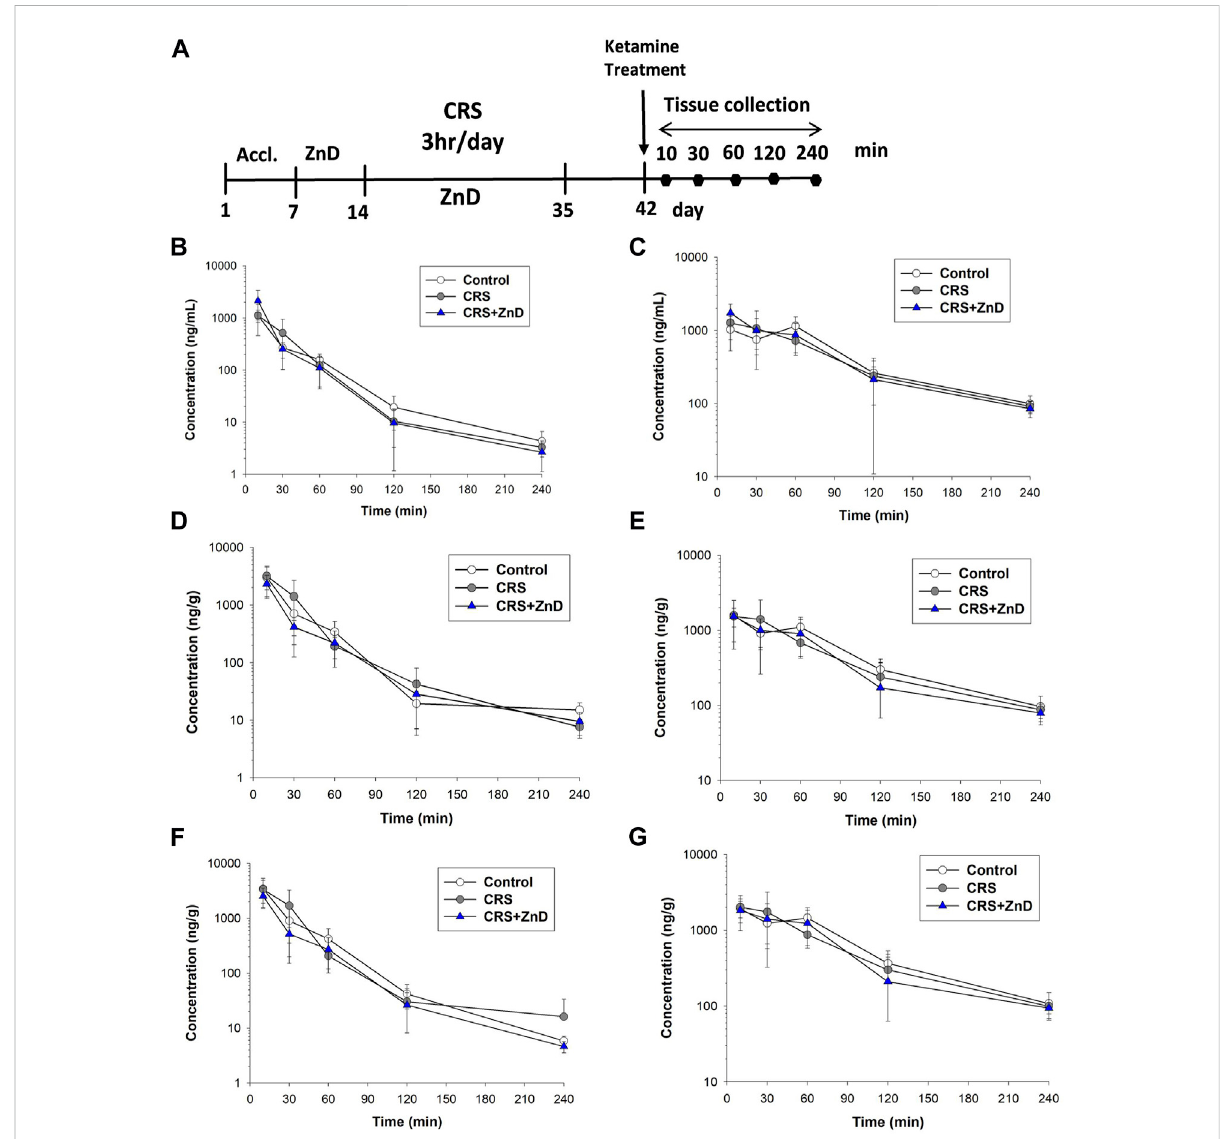
FIGURE 7 (A) Experimental schedule of drug treatment. (B,C) Concentration vs. time pro fi les of ketamine (left panel) and its metabolite hydroxynorketamine(rightpanel)inmouseserumfollowingintraperitoneal(i.p.)administrationof10 mg/kgketamine(n=6). (D,E) Concentrationvs. time pro fi les of ketamine (left panel) and its metabolite hydroxynorketamine (right panel) in mouse hippocampus following i.p. administration of 10 mg/kg ketamine (n = 6). (F,G) Concentration vs. time pro fi les of ketamine (left panel) and its metabolite hydroxynorketamine (right panel) in mouse frontal cortex following i.p. administration of 10 mg/kg ketamine (n = 6). CRS: chronic restraint stress, ZnD: zinc de fi cient